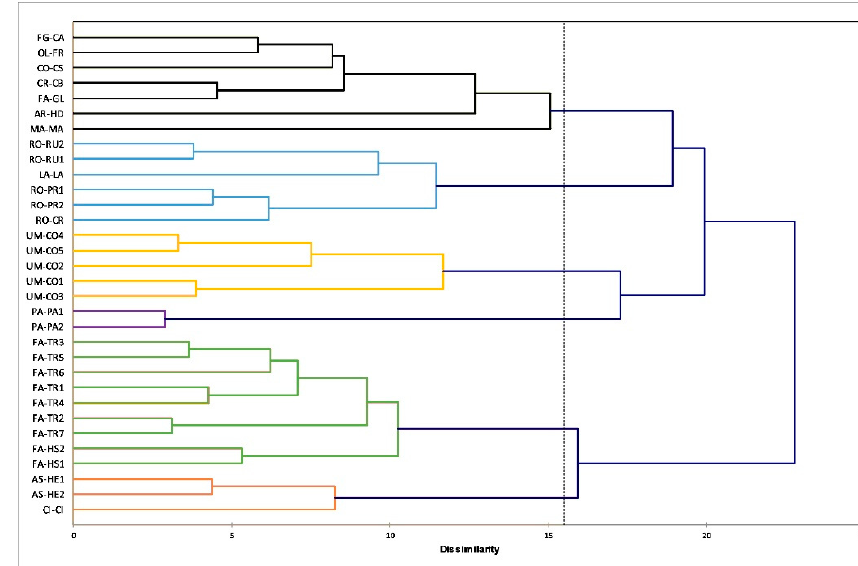
Molecules 2019 , 24 , x 9 of 13 Figure 3. Dendrogram obtained by cluster analysis performed applying the complete linkage algorithm (Euclidean distance) on the data set incorporating all pollen samples and color coordinates (L*, a* and b*), granulometry and second derivative IR data (1800–650 cm − 1 ) as variables.